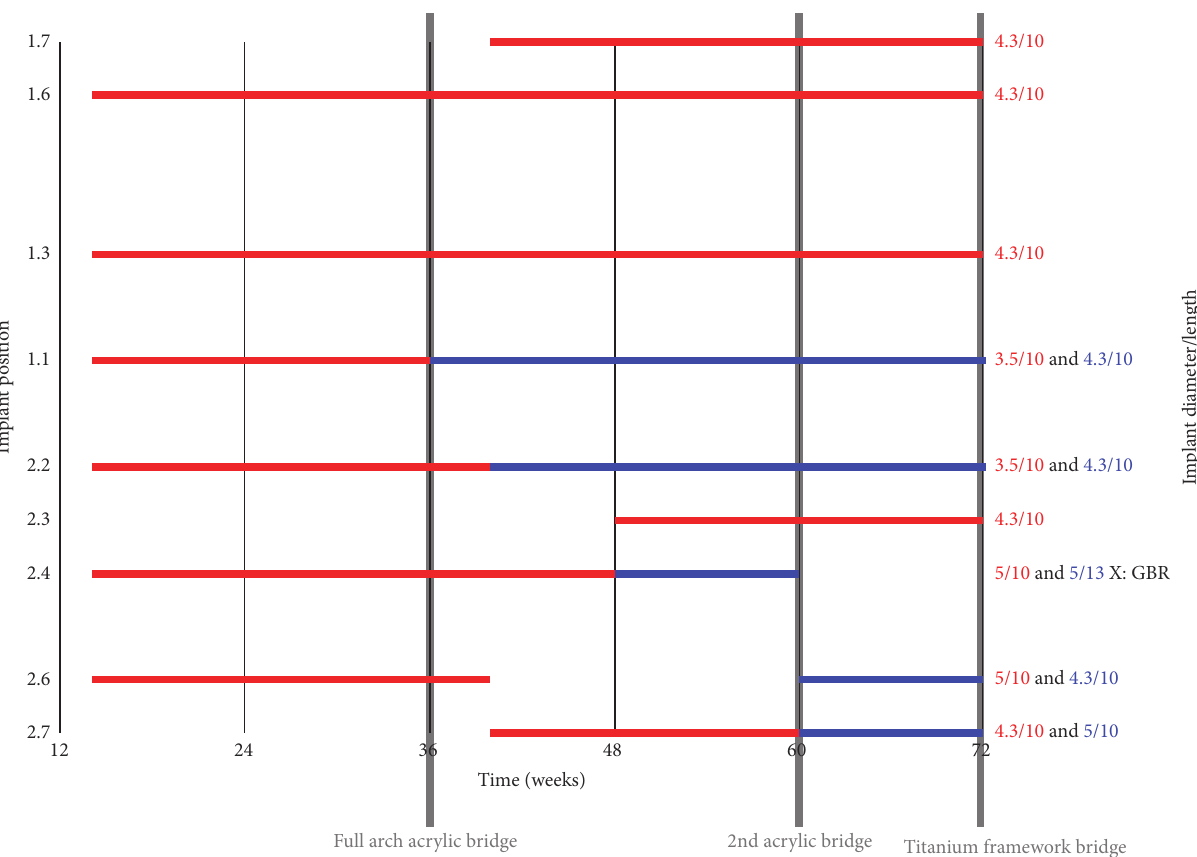
Figure 3: Time course of maxillary implant insertions and failures, ordered by position. In red a given implant first positioning and in blue the substituting implant. The initial planning included 6 implants with delayed loading. Five implants failed. The maxilla was finally rehabilitated at 72 weeks with a screwed titanium milled framework with acrylic composite teeth supported by 8 implants. No additional implant failures